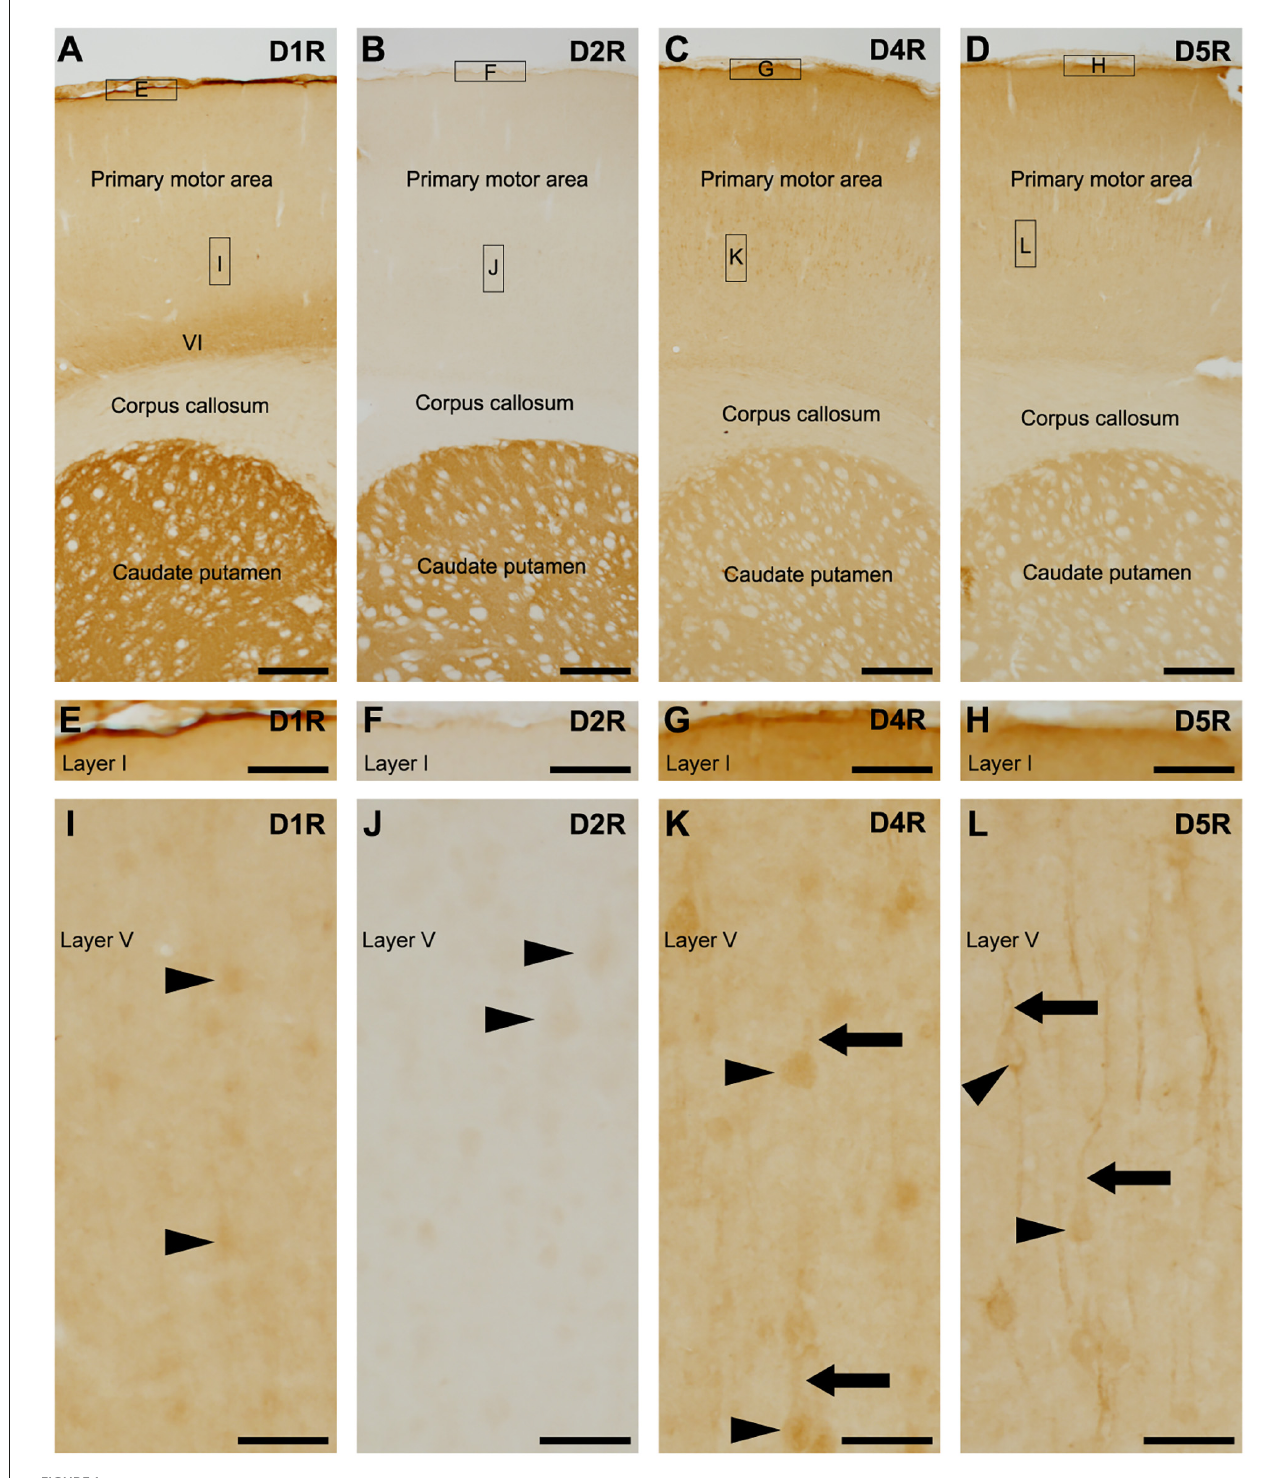
FIGURE1 Distribution of each dopamine receptor in the motor cortex and caudate putamen. (A) Representative immunohistochemistry of the frontal cortex for D1R. High-magnification images of rectangles indicated with E and I are shown in (E,I) . Moderate to strong D1R-immunoreactivities were observed in the pial surface of the cerebral cortex, layer (VI), and caudate putamen. (B) Representative immunohistochemistry of the frontal cortex for D2R. High magnification images of rectangles indicated with F and J are shown in (F) and (J) . (C) Representative immunohistochemistry of the frontal cortex for D4R. High magnification images of rectangles indicated with G and K are shown in (G) and (K) . (D) Representative immunohistochemistry of the frontal cortex for D5R. High magnification images of rectangles indicated with H and L are shown in (H) and (L) . (E–H) Immunohistochemical images of the cortical surface for D1R (E) , D2R (F) , D4R (G) , and D5R (H) . (I) Immunohistochemical images of the cortical layer V for D1R. Neuronal somata show weak immunopositive signals for D1R (arrowheads). (J) Immunohistochemical images of the cortical layer V for D2R. Neuronal somata show